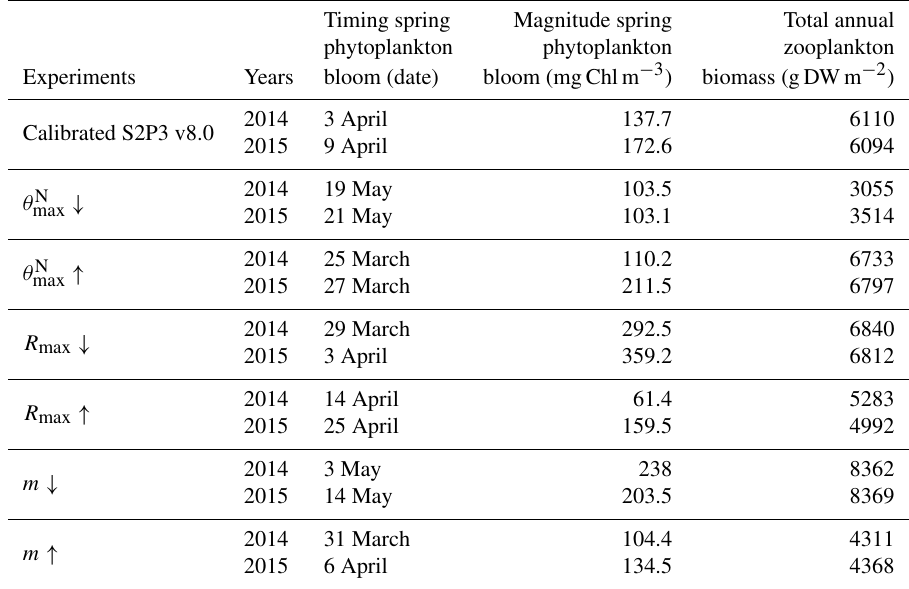
Table 2. List of the most sensitive experiments run for the S2P3 v8.0 model calibrated for the CCS location, including the year of observa- tions, timing and magnitude of the spring phytoplankton bloom, and total annual zooplankton biomass values. Timing spring Magnitude spring Total annual phytoplankton phytoplankton zooplankton Experiments